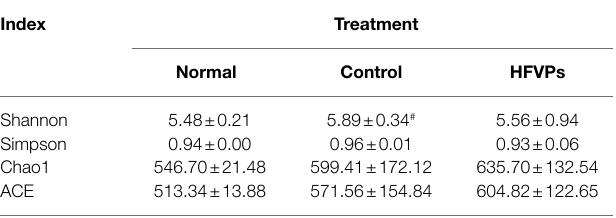
TABLE 2 | Alpha diversity evaluated using the ACE, Chao1, Simpson, and Shannon